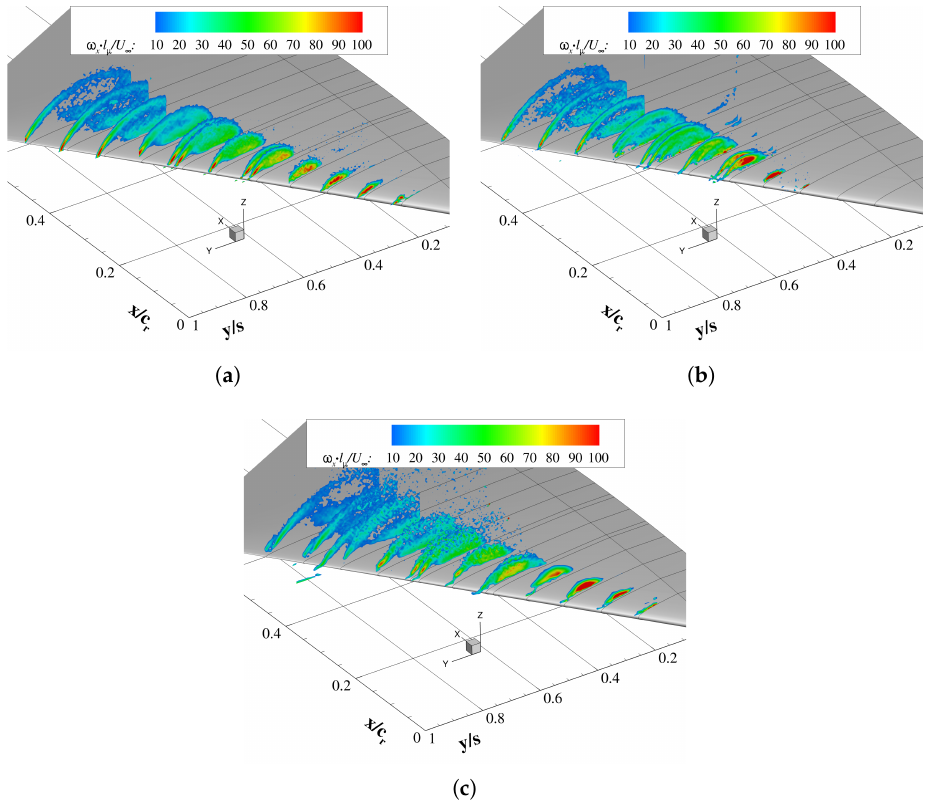
0.6 at α = 16 ◦ and x / c r ≤ ≤